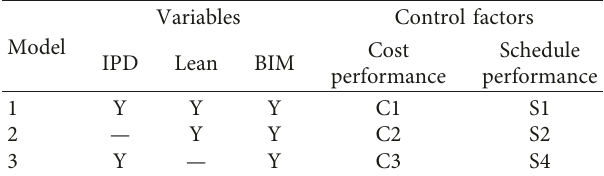
Table 2: Analyzing models and control